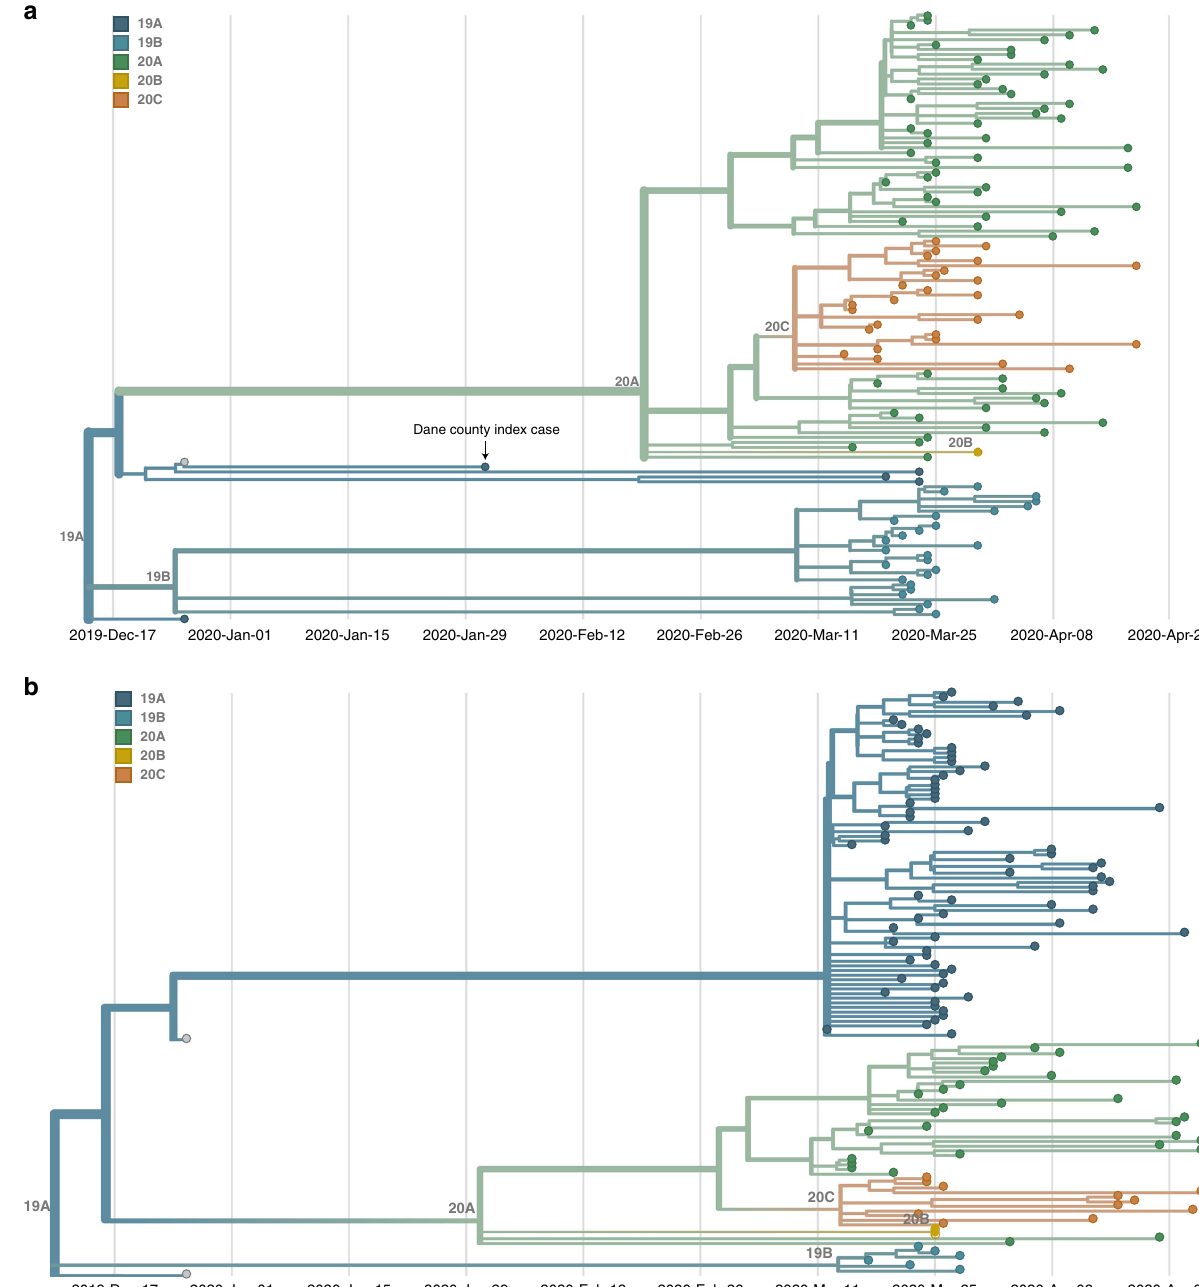
Fig. 3 Dane and Milwaukee county outbreaks are de fi ned by genetically distinct viruses. a A time-resolved phylogenetic tree built using Nextstrain tools for 122 samples collected in Dane county. b A time-resolved phylogenetic tree for 125 samples collected in Milwaukee county. Clade is denoted by color where dark blue denotes 19A, aqua denotes 19B, green denotes 20A, gold denotes 20B, and orange denotes 20C. Both phylogenies include Wuhan sequences (Wuhan-Hu-1/2019 and Wuhan/WH01/2019, shown in gray) to more effectively time-align each tree. Source data to replicate this fi gure can be found in the Source Data fi